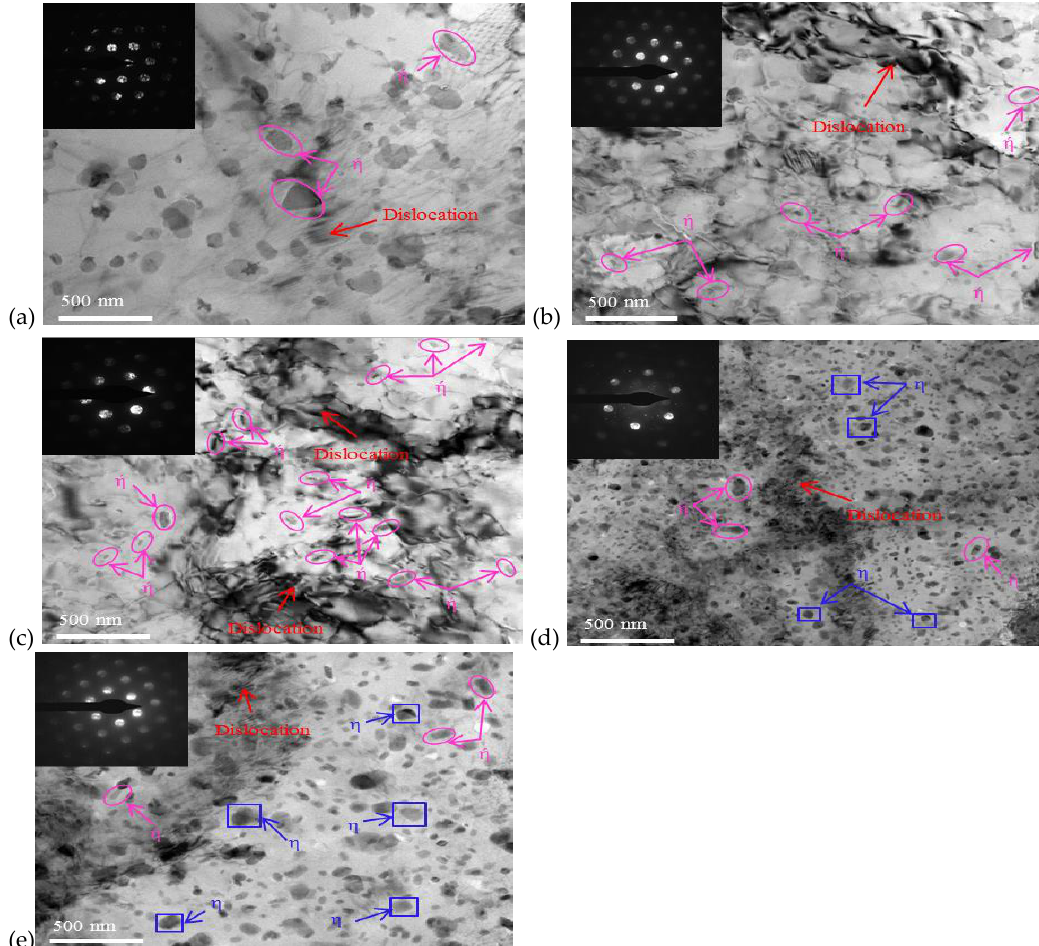
Figure 7. Bright field TEM images showing the microstructures of the pre-stretched 7055-T6 after the creep-aging tests, under various pre-stretching conditions ( a ) 0%, ( b ) 1.7%, ( c ) 3.3%, ( d ) 5%, and ( e ) 6.7%.